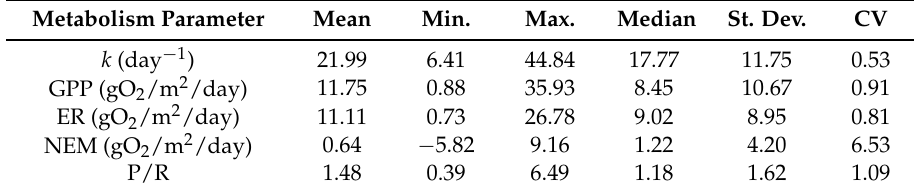
Table 5. Summary of the reaeration coefficient ( k ), gross primary productivity (GPP), ecosystem respiration (ER), net ecosystem metabolism (NEM), and production to respiration ratio (P/R) of 12 headwater streams in the Grand River Watershed. Metabolism